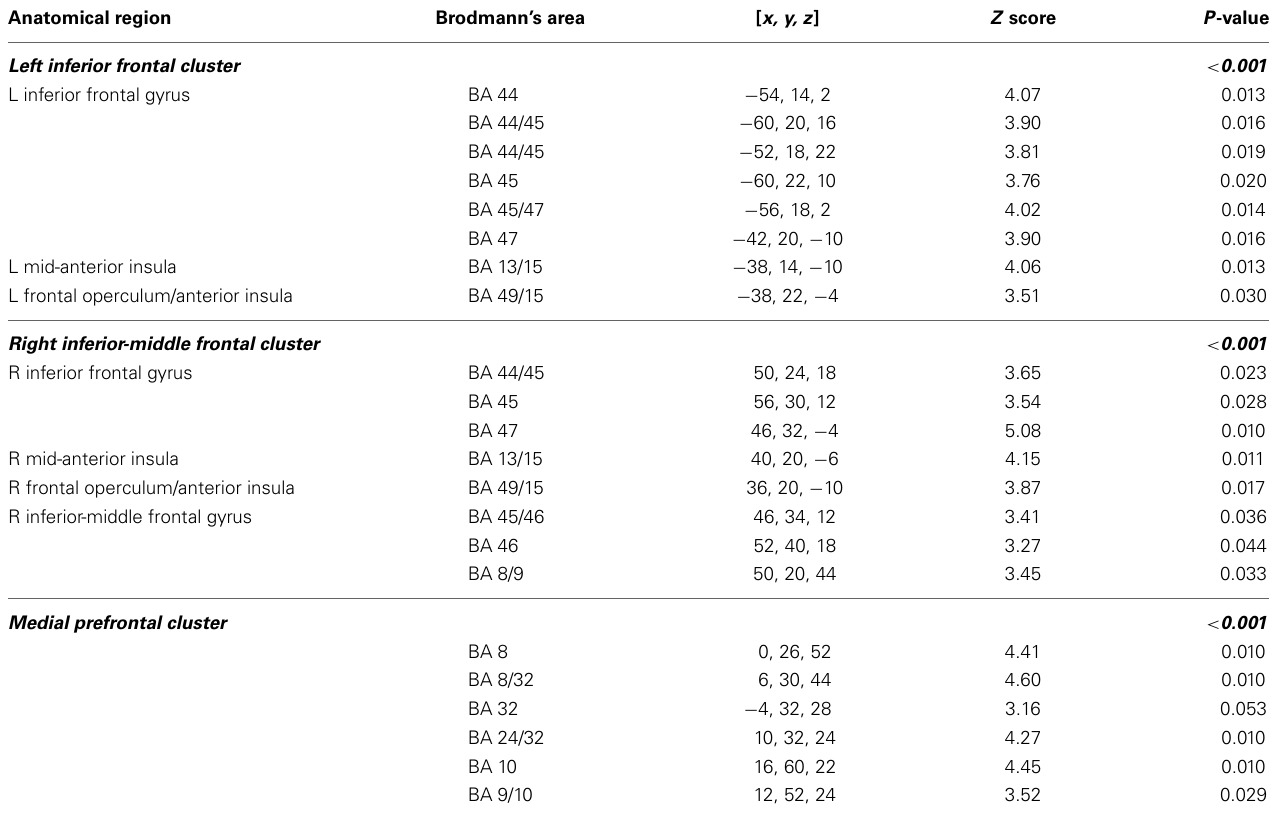
Table 3 | Preference classification Day 5. Anatomical